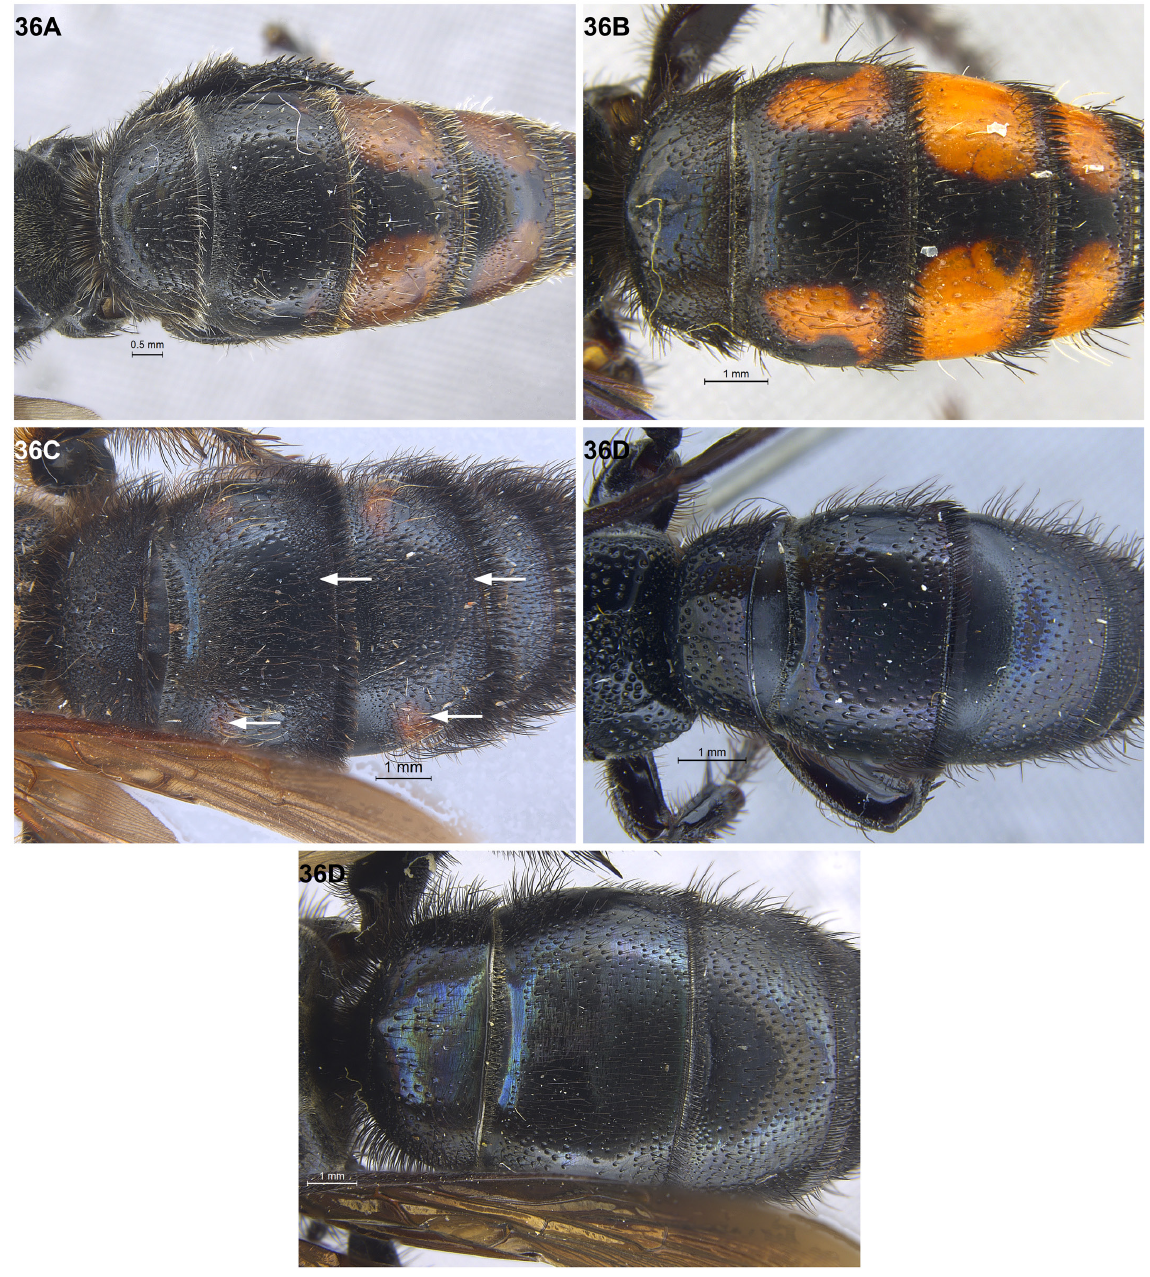
Fig. 36. Females, T1–T3, dorsal view. A . Scolia binotata Fabricius, 1804 . B . Sc. binotata orange var. C . Sc. clypeata pseudovollenhoveni Betrem, 1933. D . Sc. pakshaoensis sp. nov., holotype (CAS). E . Sc. superciliaris de Saussure & Sichel, 1864